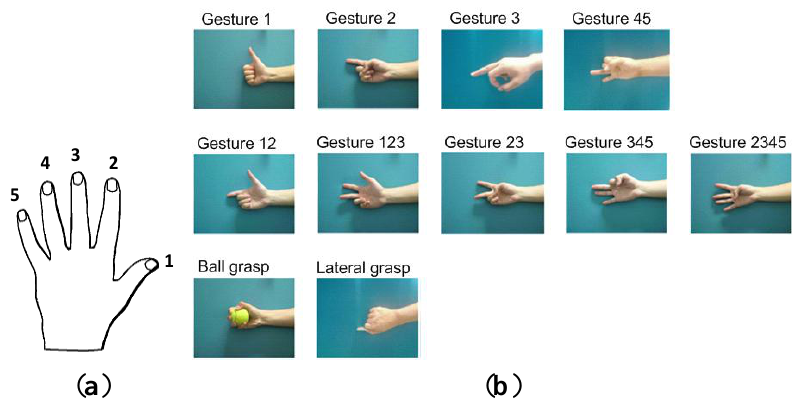
Figure 8. ( a ) Finger label. ( b ) Eleven predefined gestures.